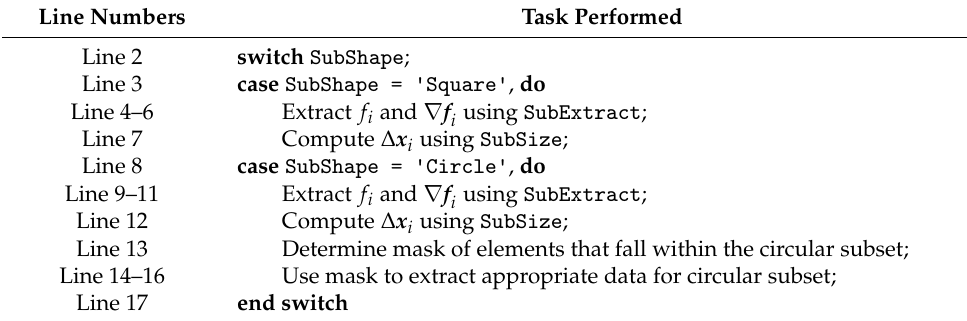
Table 6. SubShapeExtract algorithm summary.